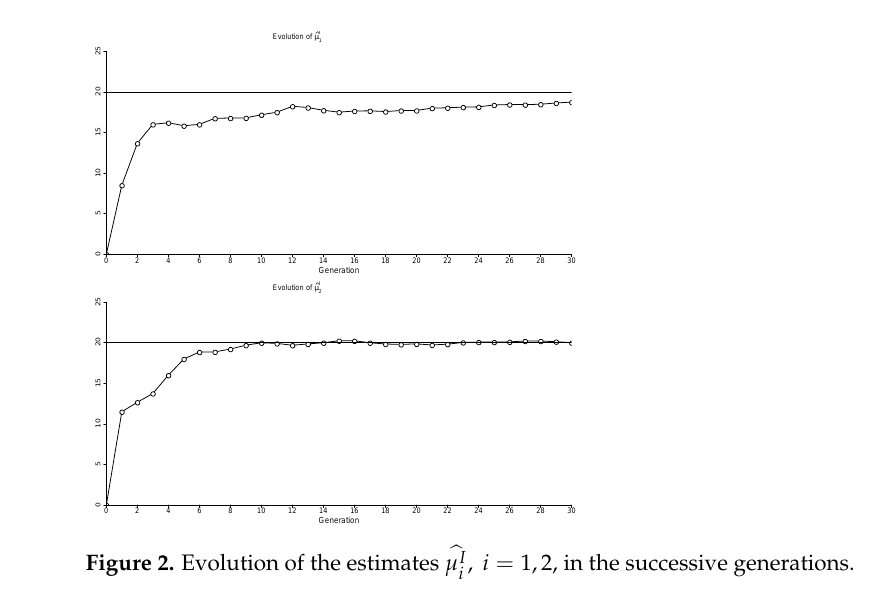
, i = 1,2, in the successive generations. i